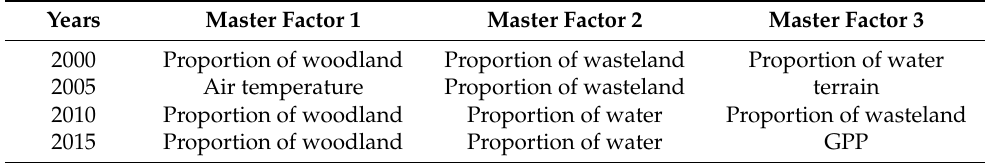
Table 8. Main control factors in 2000, 2005, 2010, and